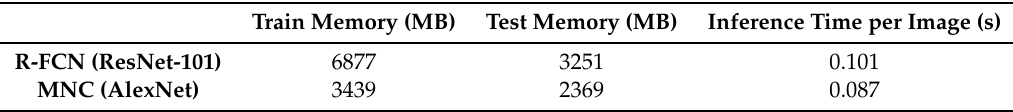
Table 2. Overview of hardware statistics for both methods. Timings were done on images of